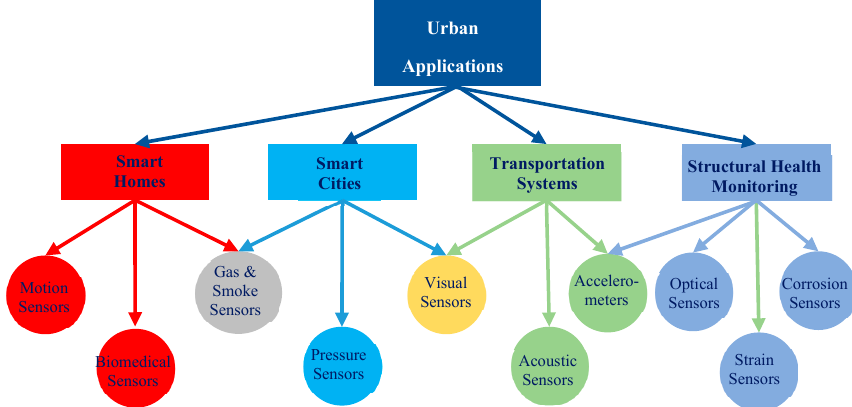
Figure 16. The subcategories of the urban applications of WSNs and the types of the sensors used in them.